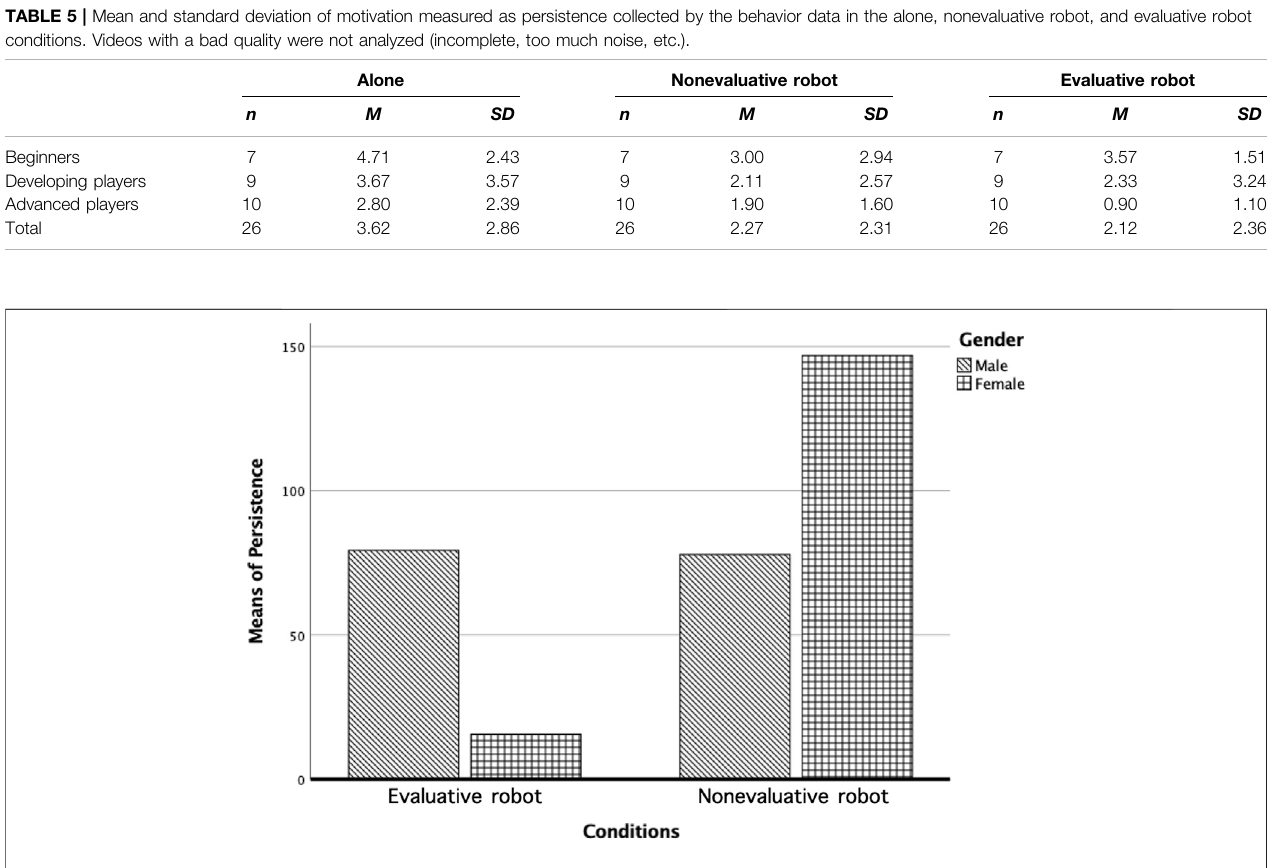
Frontiers in Robotics and AI |